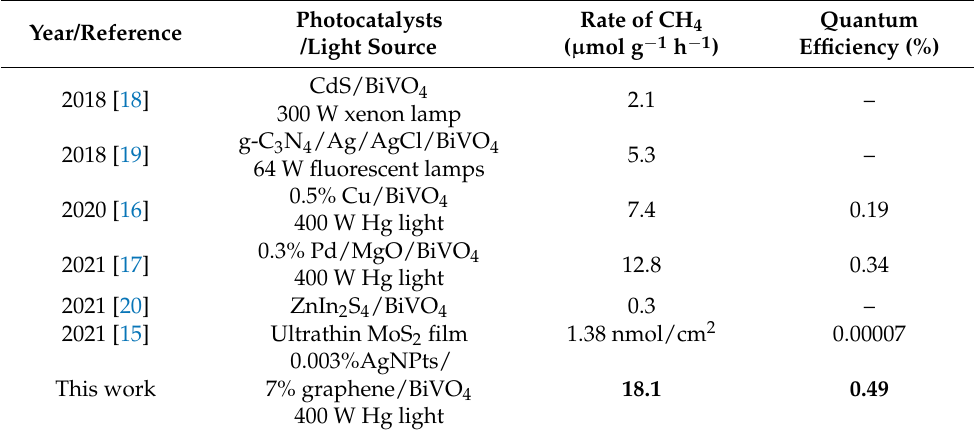
Table 1. Production rate of CH 4 on various BiVO 4